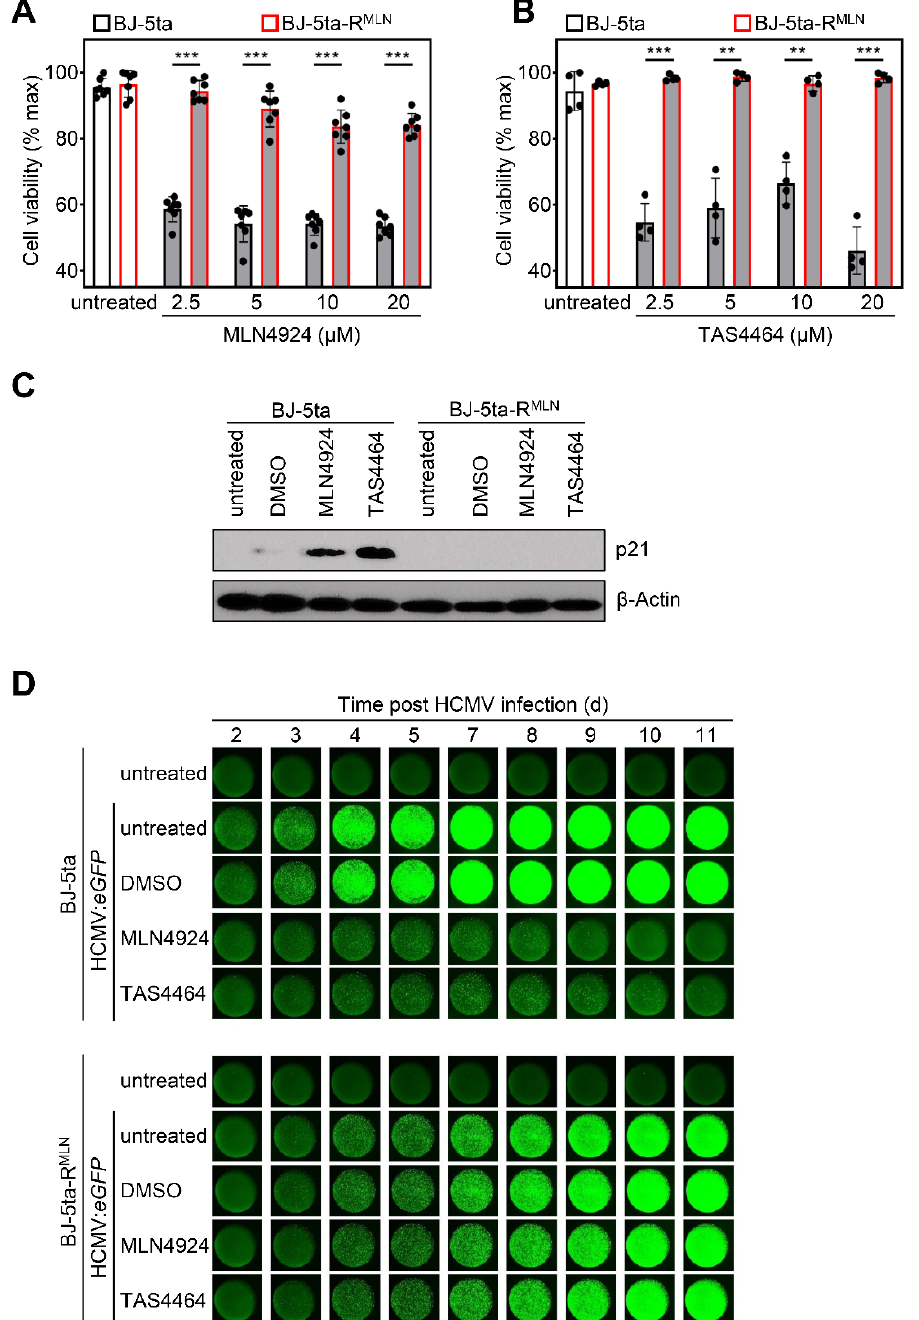
Figure 4. Antiviral effects elicited by MLN4924 and TAS4464 are absent in MLN4924 ‐ resistant cells. ( A ) BJ ‐ 5ta parental cells and MLN4924 ‐ resistant cells (“BJ ‐ 5ta ‐ R MLN ”) were exposed to increasing concentrations of MLN4924 or ( B ) TAS4464 to assess the cell proliferation during a 72 h period. Asterisks indicate the level of statistical significance assessed by a two ‐ sided, heteroscedastic t test (** p < 0.01; *** p < 0.001). ( C ) Parental and BJ ‐ 5ta ‐ R MLN cells were left untreated or were treated with DMSO, MLN4924 (5 μ M), or TAS4464 (2 μ M). Cells were lysed, and the p21 stabilization was assessed by immunob ‐ lotting analysis. ( D ) In addition to ruxolitinib (4 μ M), BJ ‐ 5ta parental and BJ ‐ 5ta ‐ R MLN cells were left untreated or were treated with the solvent (DMSO), MLN4924 (5000 nM), or TAS4464 (2000 nM) and briefly afterwards infected with HCMV: eGFP . HCMV ‐ induced fluorescence activity was visualized using a Bioreader at indicated time periods after infec ‐ tion. The experiment was conducted in quadruplicate, and one representative well is shown.